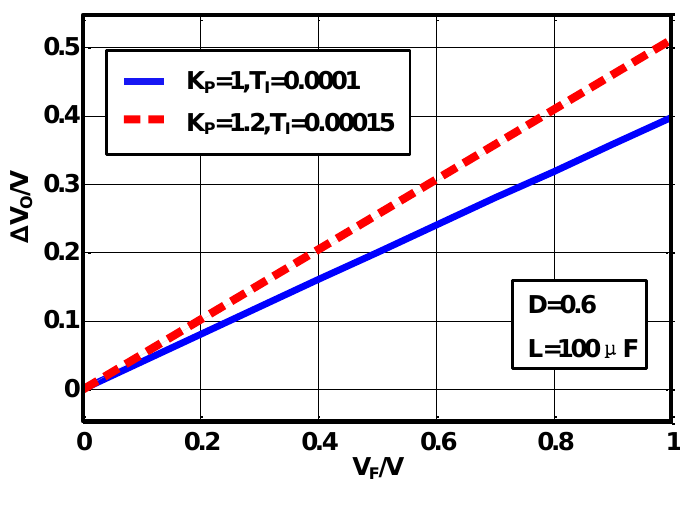
Figure 4. Simulated steady state error of the output voltage under different PI parameters V and F